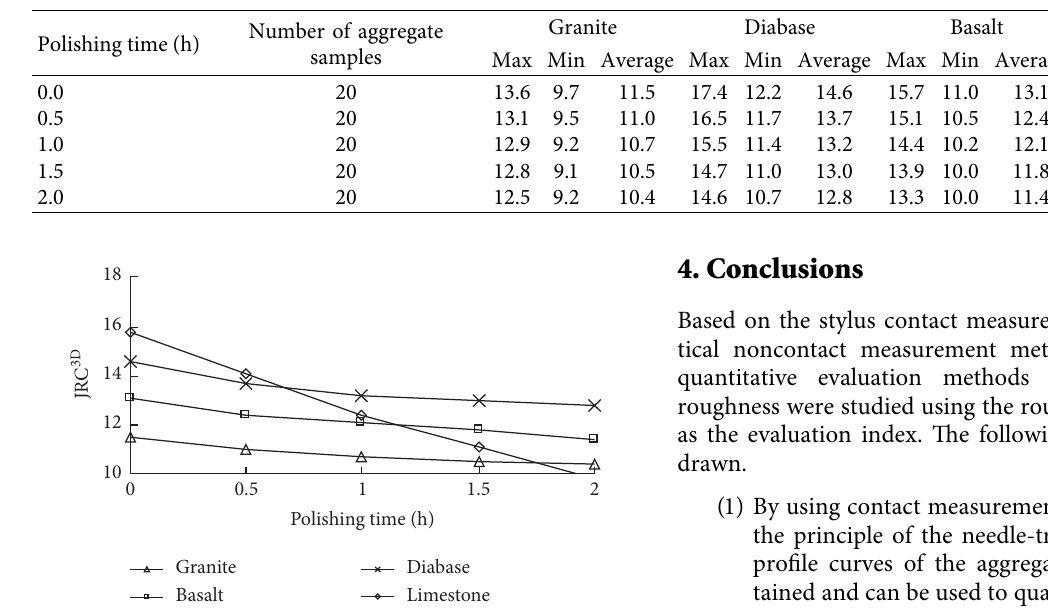
Figure 7: Variation trend of aggregate roughness.